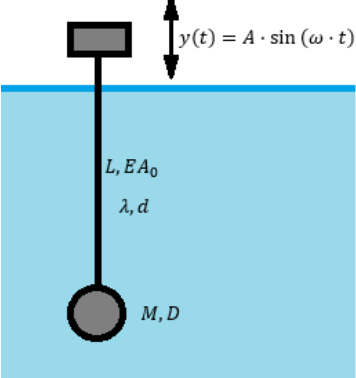
Figure 3. Zhu’s experiment